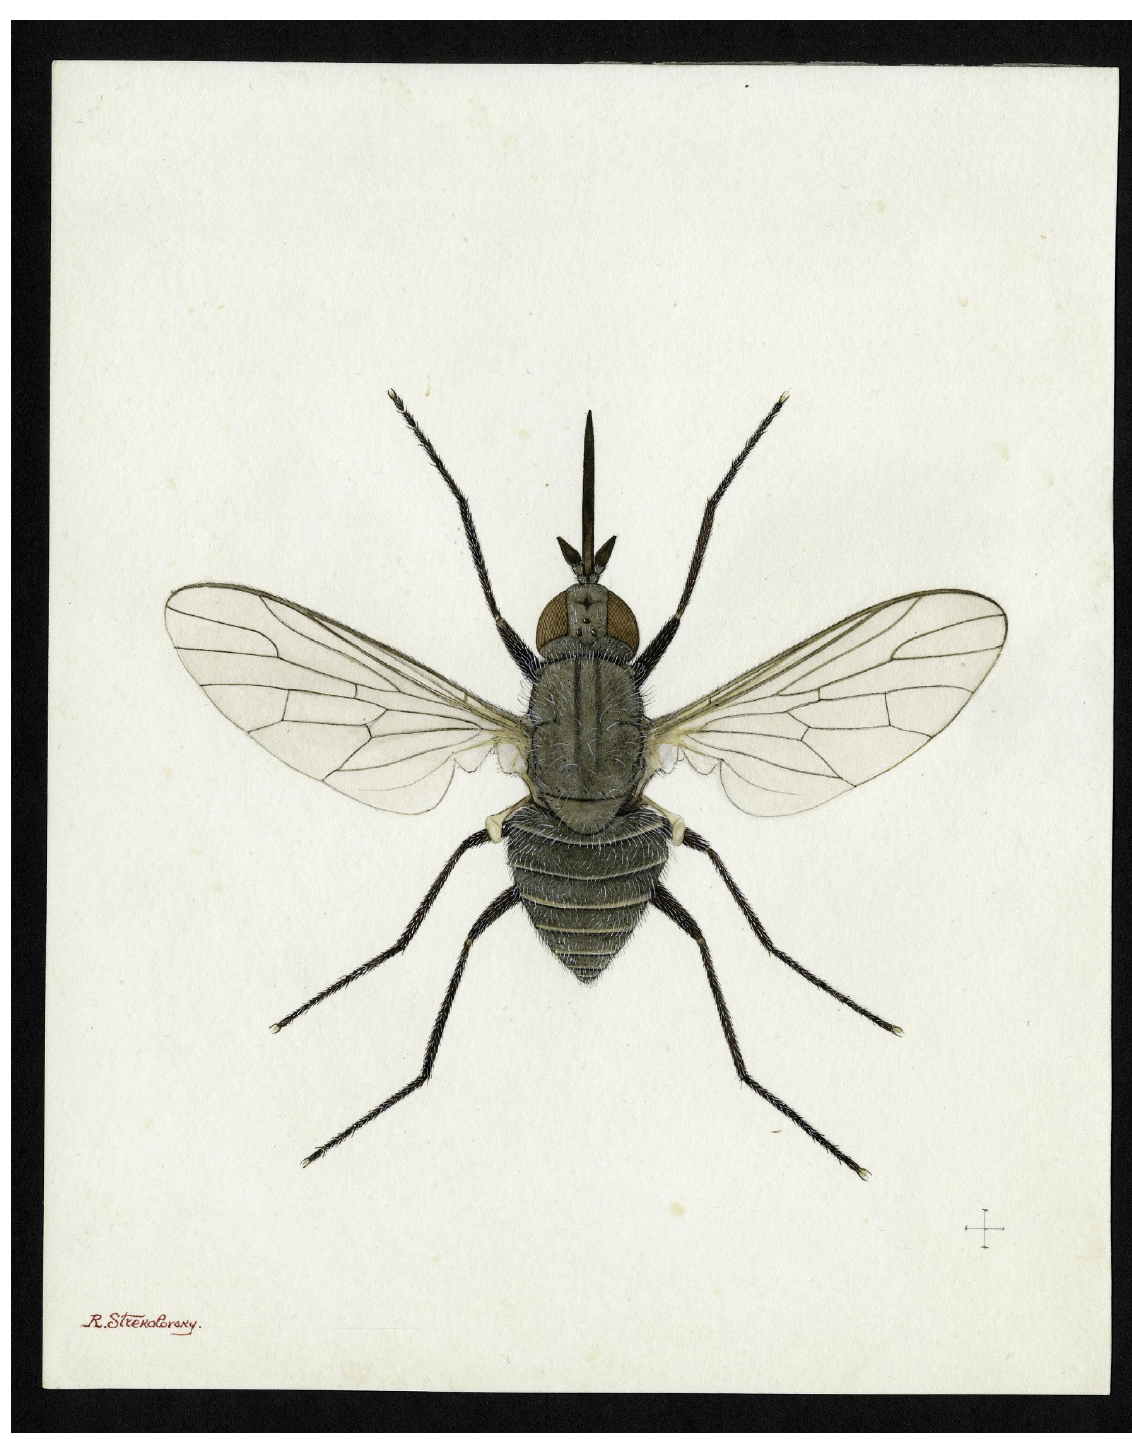
Fig. 44. Protypusia deserticola (Efflatoun, 1945) gen. et comb. nov. Smithsonian Institution Archives. Image